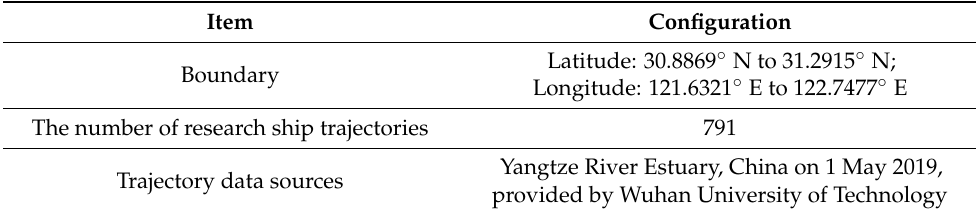
Table 1. Description of the case